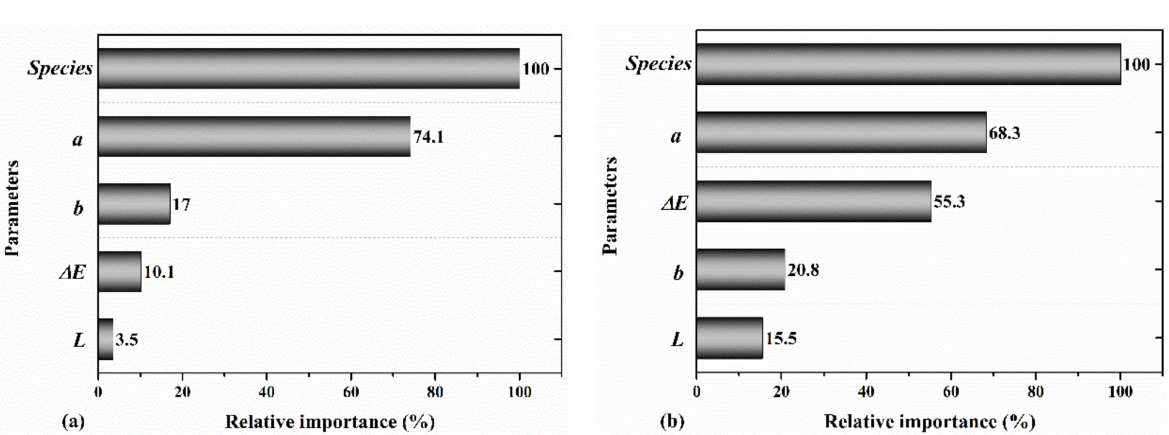
Figure 10. The relative importance of wood species, a , b , L , and ∆ E for predicting the ( a ) MOE and ( b ) MOR. The last model, which used the wood species, color parameters ( a , b , L ), total color change ( ∆ E ), and variation in the color parameters ∆ (a, ∆ b , and ∆ L ), did not make a noticeable improvement in the prediction accuracy of MOE (R 2 = 0.88 for the test data)